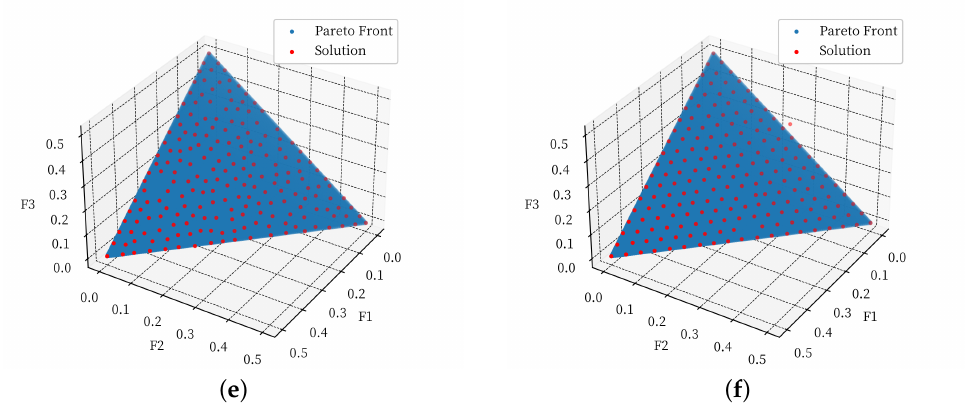
Figure 6. Comparison Between the Pareto Front and the Final Population Solution Set Ob- tained by the Six Different Algorithms on DTLZ1 Test Problem Set. Subfigures ( a ) AGEMOEA, ( b ) MOEA/D-URAW, ( c ) NSGA-II-SDR, ( d ) CMOPSO, ( e ) MOEA/D-DAE, and ( f ) MOEA/D-DPAW correspond to the running results of algorithms AGEMOEA, MOEA/D-URAW, NSGA-II-SDR, CMOPSO, MOEA/D-DAE, and MOEA/D-DPAW,